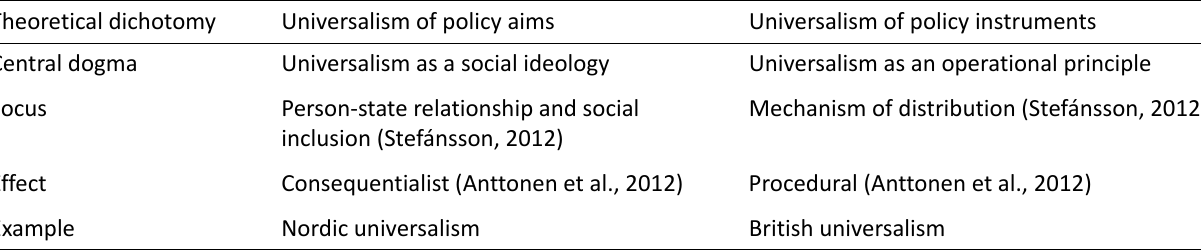
Table 1. Universalism as policy aim compared to universalism as policy instrument.